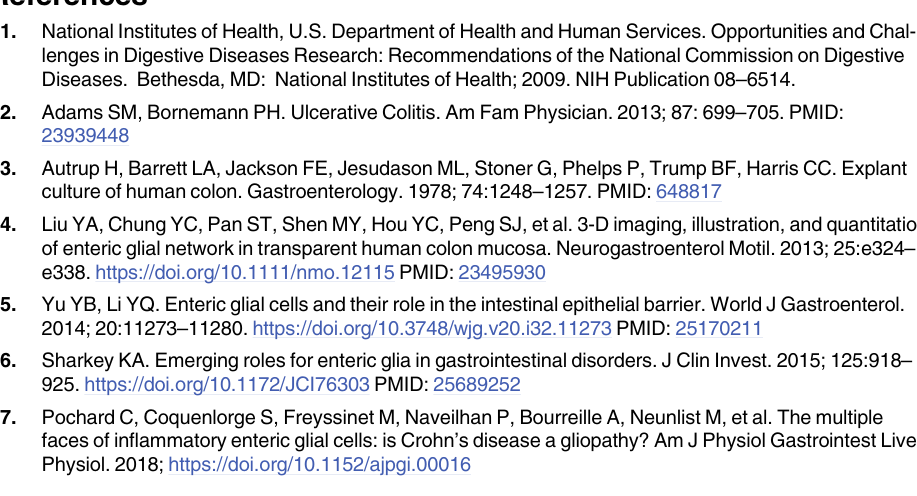
S1 Table. Supernatant metabolite abundance fold differences when comparing across oxy- gen concentrations and in the presence or absence of